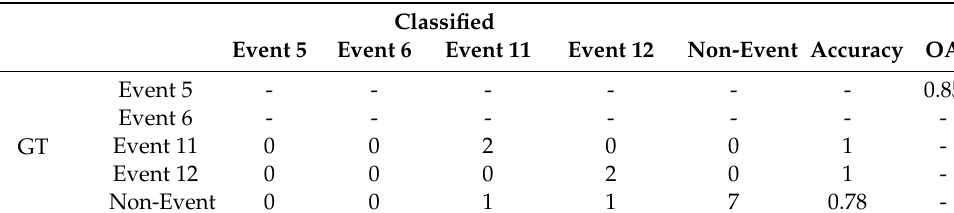
Event classification using the hybrid approach for one VIRAT video: